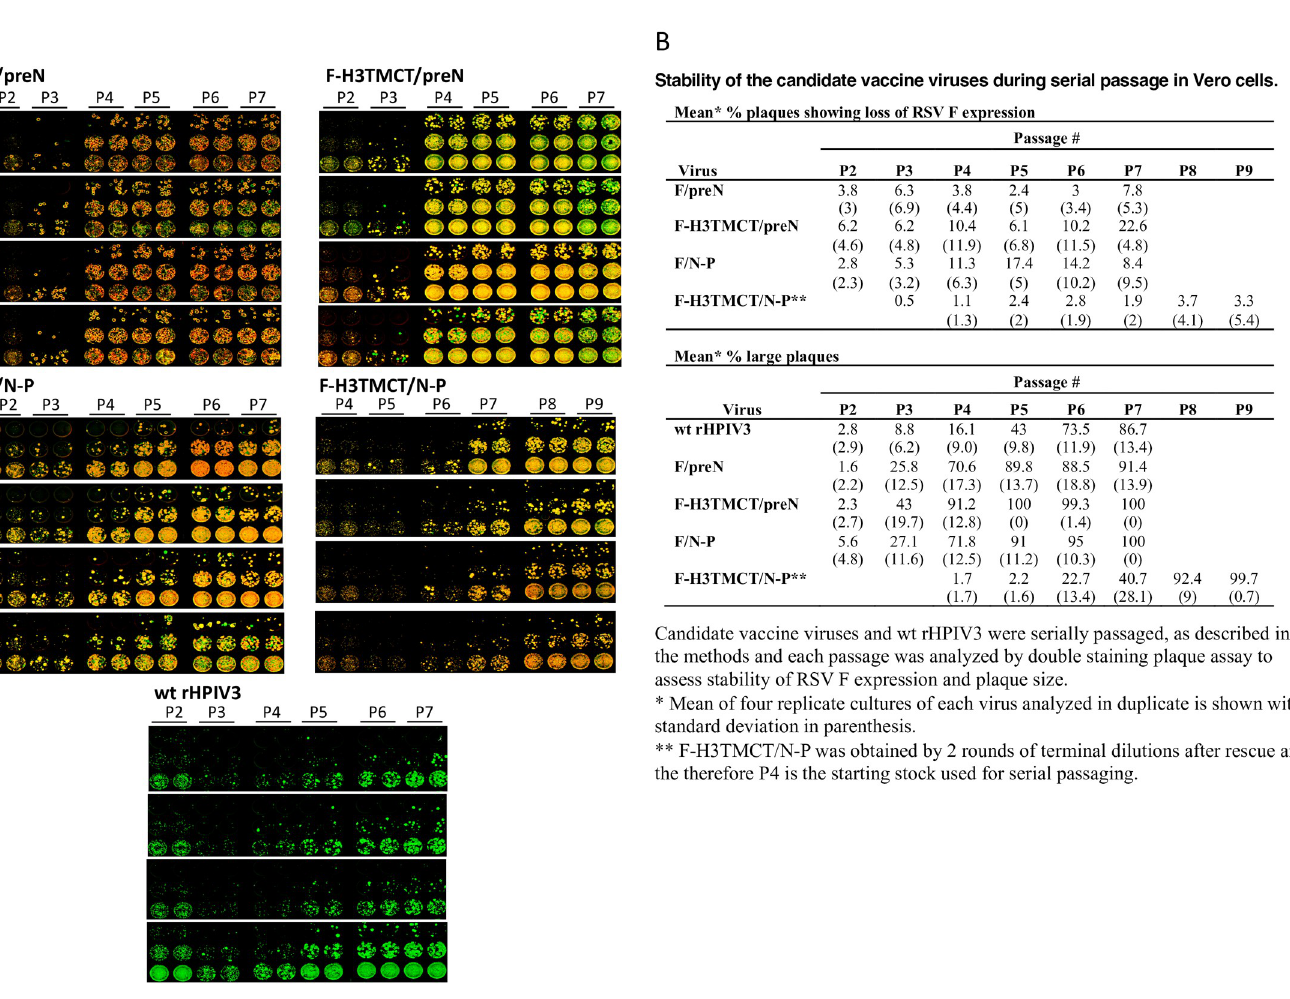
Fig 9. Serial passage of HPIV3-RSV F vectors in Vero cells: Analysis of the stability of RSV F expression. The P4 stock of F-H3TMCT/N-P, P2 stock of F/preN, F-H3TMCT/preN, and F/N-P, or wt rHPIV3 was passaged serially five times in Vero cells, with four replicates of each. Virus samples from each passage were analyzed by double-staining plaque assay on Vero cells to measure the stability of RSV F expression. A. Scans of the immunostained monolayers made with the Odyssey infrared imaging system (Licor) using 800-nm and 680-nm channels: HPIV3 plaques expressing RSV appear as yellow, while HPIV3 plaques in which expression of RSV F was silenced appear as green. Large plaque variants also are evident in some wells. B . Green plaques indicating loss of RSV F expression, and large plaque variants, were counted and are shown as mean % plaques with loss of RSV F expression and mean % large plaques.